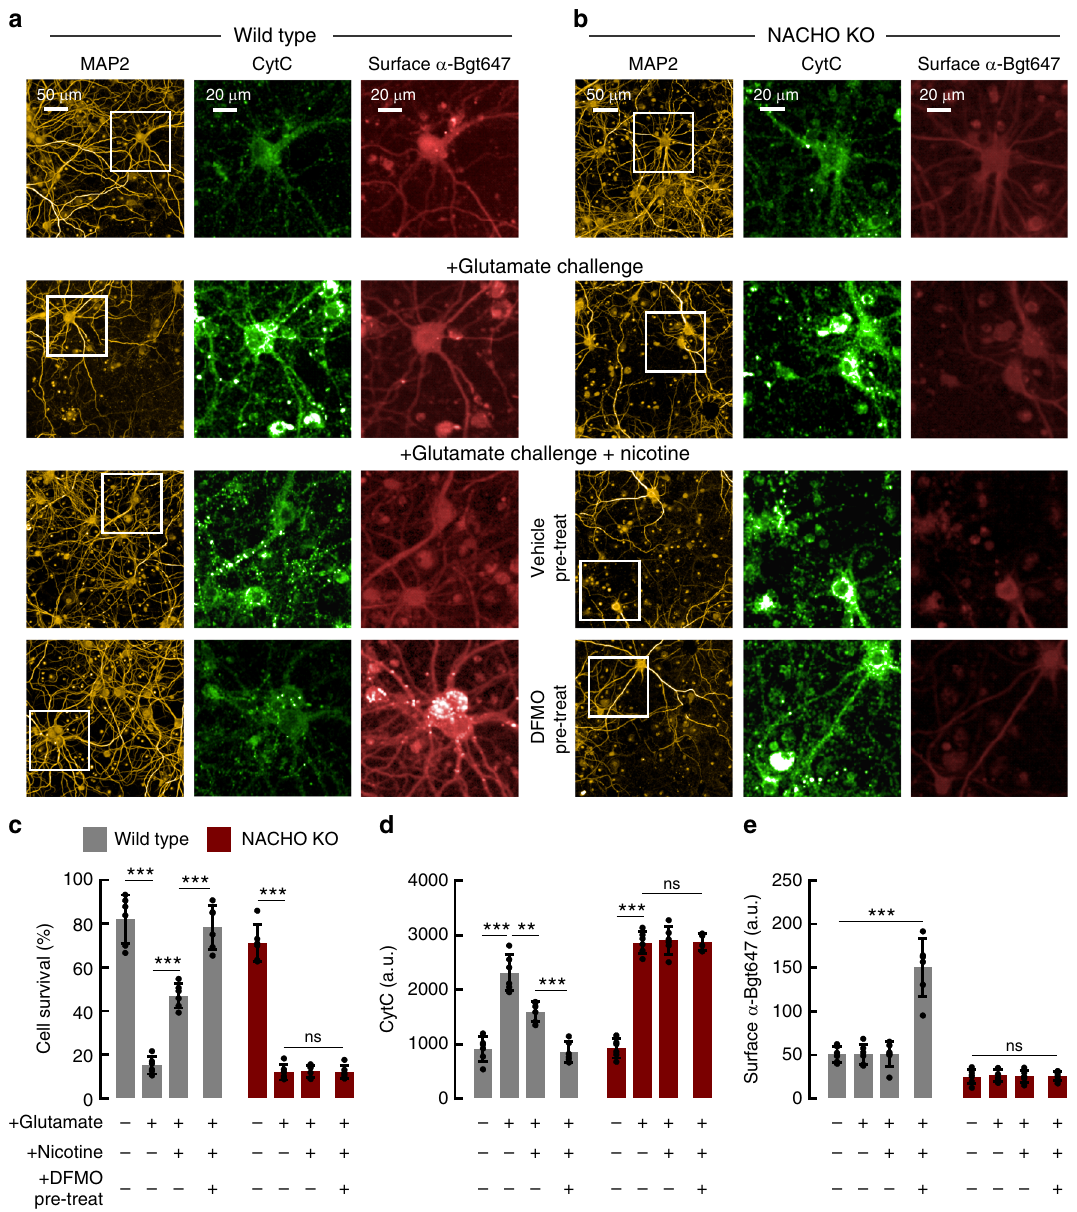
Fig. 7 DFMO promotes nicotine-mediated neuroprotection in a NACHO-dependent fashion. a, b Images of cortical neurons (DIV 20) from wild-type ( a ) or NACHO KO ( b ) mice. As indicated, neurons were pretreated with DFMO (5 mM, 4th row) or and challenged with 30 μ M glutamate (Glu, 2nd – 4th row) in the absence (2nd row) or presence (3rd – 4th row) of 100 μ M nicotine. The cells were stained for MAP2 (left panel) and cytochrome-C (CytC middle panel) and surface α -Bgt647 (right panel). White squares indicate regions that are magni fi ed. c – e Graphs quantify neuronal survival ( c ), CytC ( d ) and surface α -Bgt647 ( e ) ( n = 6). Acute nicotine increases cell survival ( p < 1e − 4 ) and reduces CytC mobilization ( p = 0.0002) during glutamate toxicity in wild-type neurons, but not in NACHO KO neurons ( p = 0.9). DFMO pre-treatment further promotes nicotine-mediated cell survival ( p < 1e − 4 ) and reduces CytC mobilization ( p = 0.0002) in wildtype neurons. DFMO signi fi cantly enhances surface α -Bgt647 labeling of wild-type ( p < 1e − 4 ) but not of NACHO KO neurons ( p = 0.9). ** p < 0.01, *** p < 0.001, n.s = not signi fi cant, one-way ANOVA between the groups. Data displayed as mean ± SD. Source data for panel c – e are provided as a Source Data fi